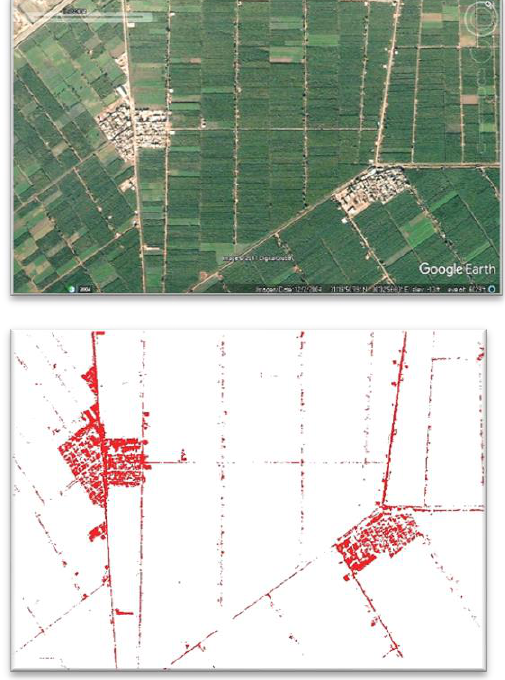
Figure 7: Scattered Built up areas in Al-Maamoura - Source: Google Earth